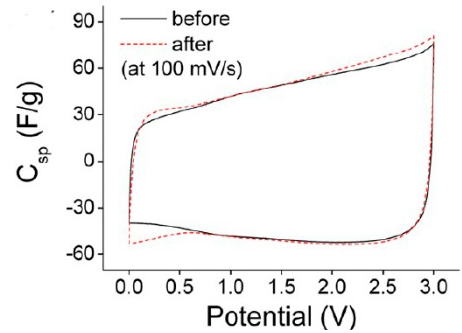
Figure 2. Cyclic voltammetry curves measured before and after 200 bending cycles [46]. Copyright 2012, American Chemical Society